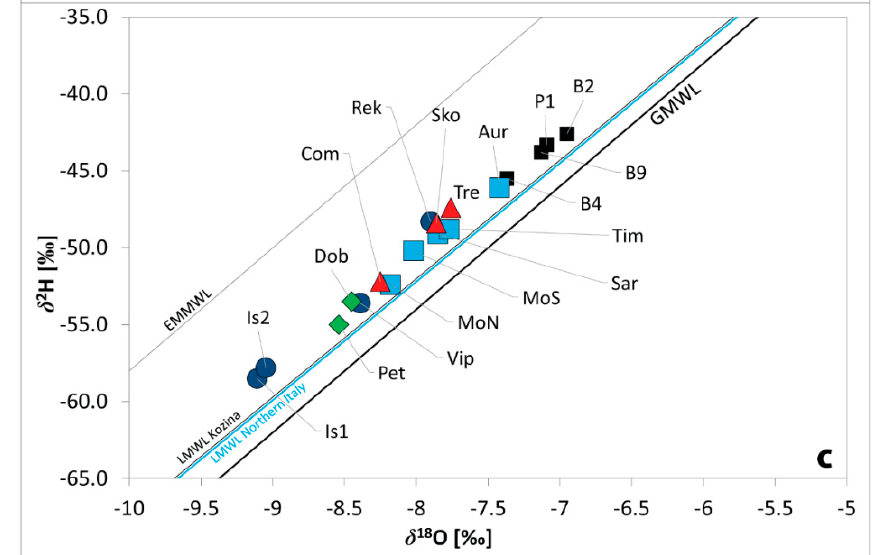
Figure 6. δ 18 O versus δ 2 H isotopic values of the samples collected: ( a ) results related to data collected in September 2012 during extreme low flow conditions; ( b ) results related to data collected in April 2013 in correspondence of the decreasing limb of a high flood; ( c ) results related to data collected in April 2014 in correspondence of the decreasing limb of a moderate flood. Legend for Figure 6a–c Blue circles represents the surface waters, black squares are related to the piezometers, springs are in sky-blue square and caves in red triangle. The reference meteoric water lines as GMWL [67], Eastern Mediterranean Meteoric Water Line (EMMWL [71]) and Local Meteoric Water Lines (LMWLs) defined for Slovenia (Kozina) [69] and Northern Italy [68] are shown.